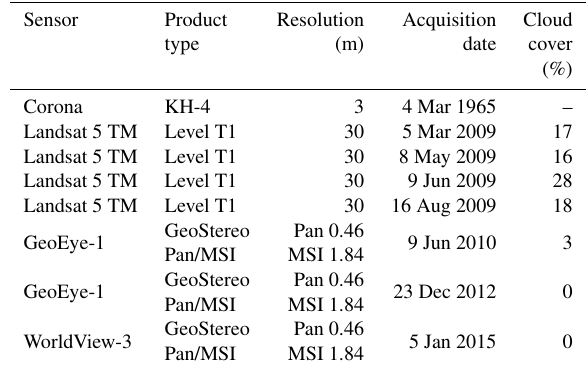
Table 1. Satellite imagery used in the